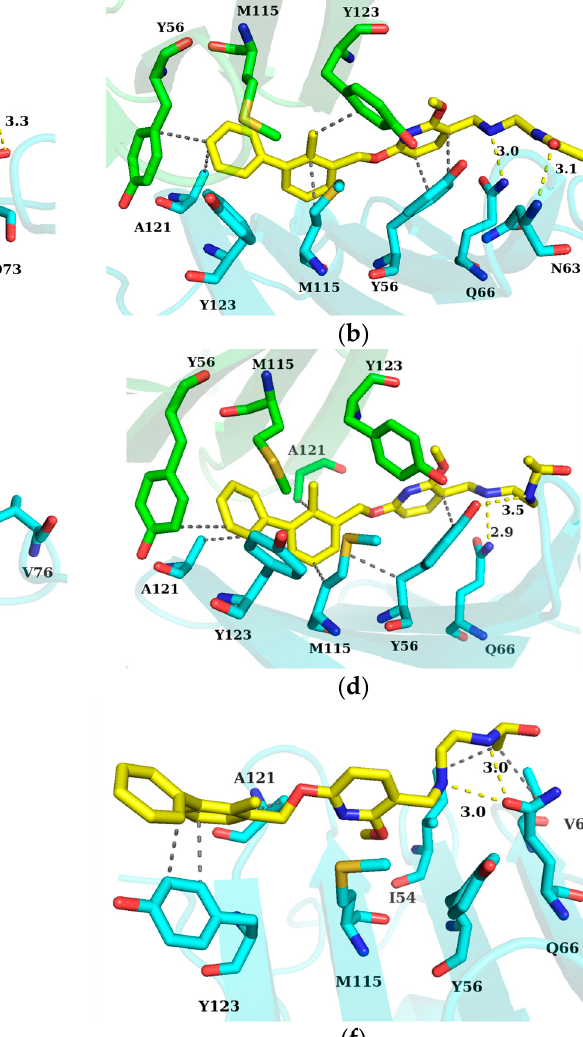
Table 3. Hydrogen bond occupancy of the systems.